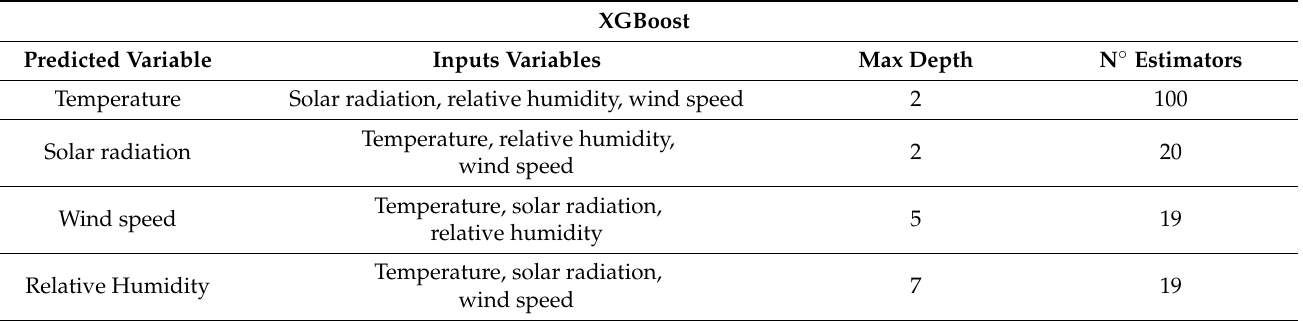
Table 5. Tuning parameters for the XGboost technique.